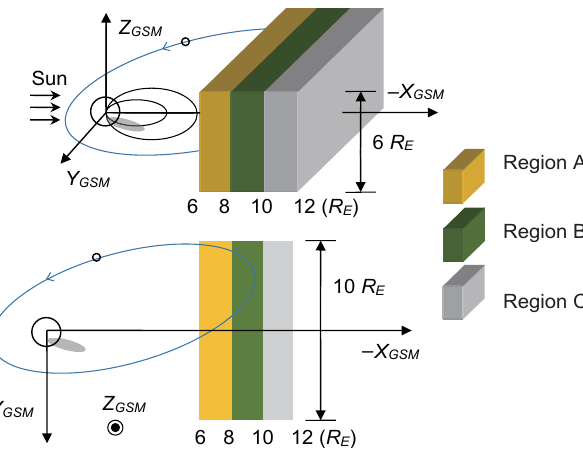
Figure 1. Three subregions chosen for analysis. The subregions are divided by GSM- X coordinates. The top and bottom panels show the subregions in GSM coordinates and in the GSM- XY plane, re-